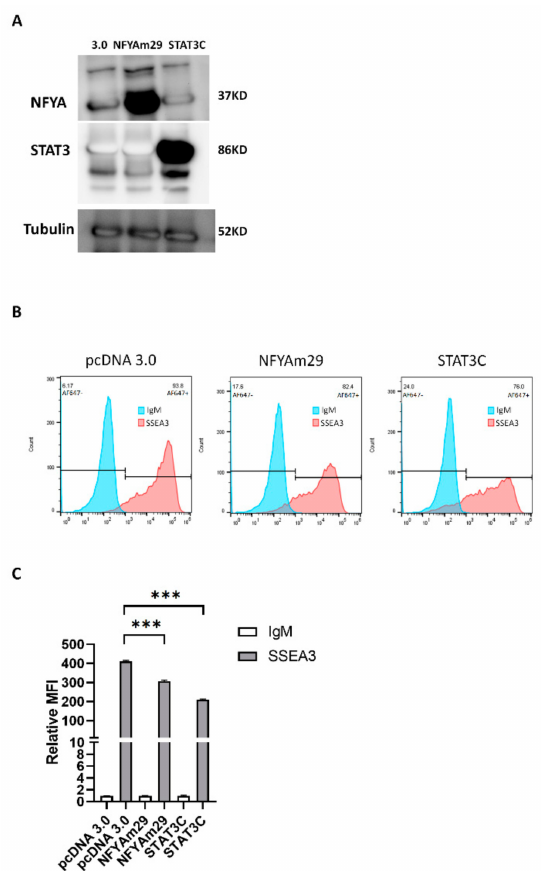
Figure 4. NFYAm29 and STAT3C repress SSEA3 synthesis in 2102Ep cells. ( A ) Overexpressed NFYAm29 and STAT3C were detected by western blotting. Tubulin served as the loading control. 3.0 means empty vector pcDNA 3.0. ( B ) Flow cytometry showing the amounts of SSEA3 on 2102Ep cells after transfection with pcDNA 3.0 or NFYAm29 or STAT3C. ( C ) Relative mean fluorescence intensity (MFI) after staining for SSEA3. The synthesis of SSEA3 was significantly reduced in cells transfected with pcDNA 3.0 containing the NFYAm29 or STAT3C sequence compared with cells transfected with an unmodified pcDNA3.0 (control) (***, p <